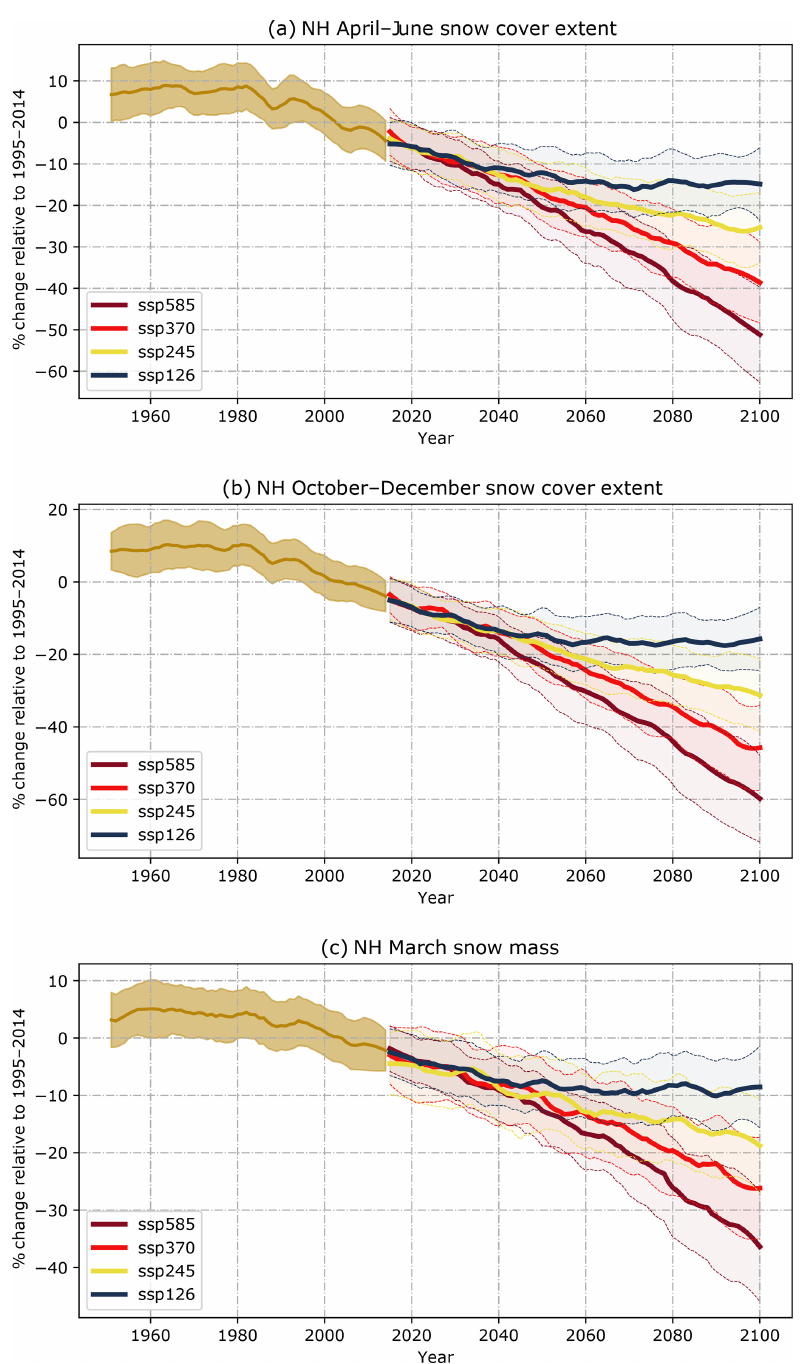
Figure 8. Time series of (a) NH spring (April–June) and (b) autumn (October–December) snow cover extent and (c) March snow mass changes (relative to the 1995–2014 average); multi-model mean of the first ensemble members of the historical and scenario runs with inter-model standard